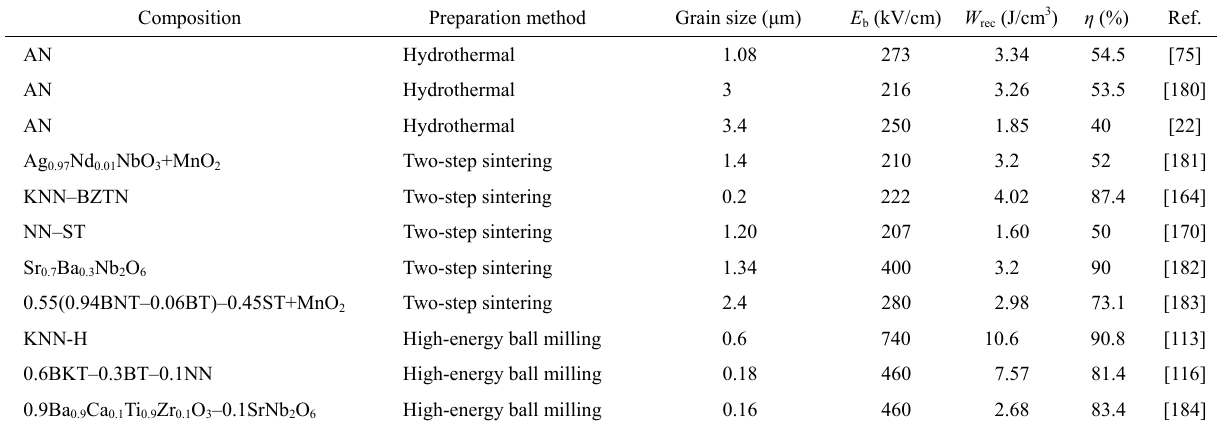
Table 4 Energy storage performance of fine-grain